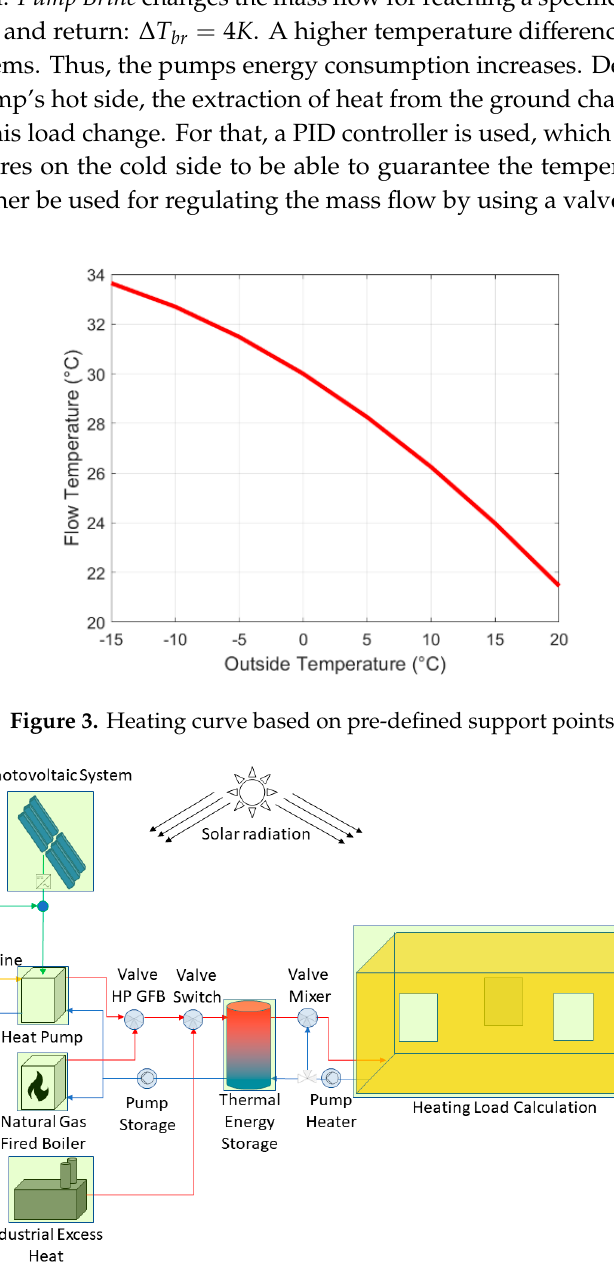
Figure 4. Heating system derived from the superstructure, including actuators.